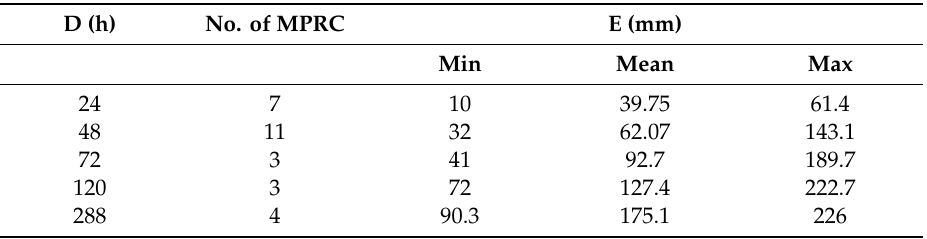
Table 1. Values of number of maximum probability rainfall conditions (MPRC), minimum, mean, and maximum values of event rainfall (E) for various duration (D).